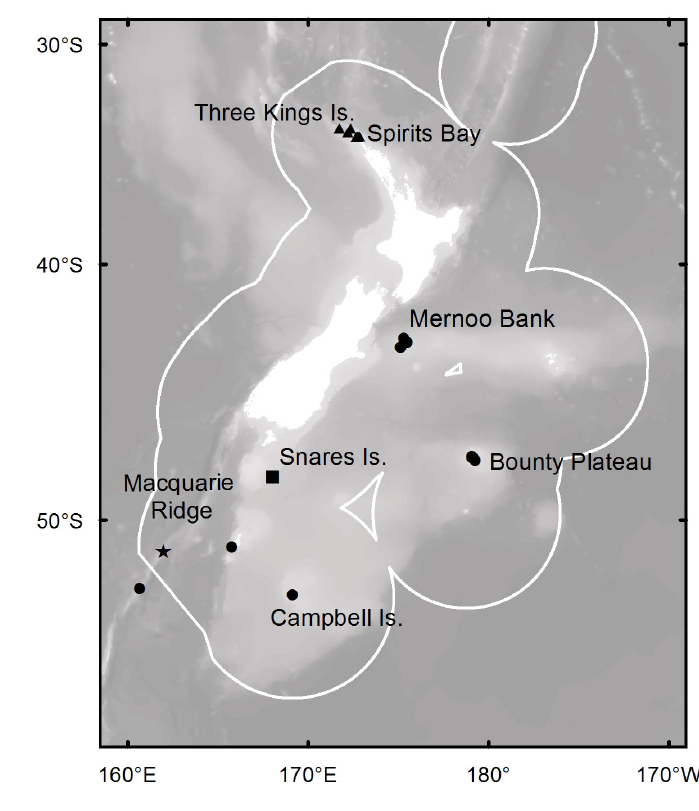
Fig. 1. Study area showing the collection localities for: Lamellomorpha strongylata Bergquist, 1968, around Middlesex Bank, Three Kings Islands, and Spirits Bay (triangles); L. australis Kelly & Cárdenas sp. nov., Bounty Platform, Campbell Plateau, Solander Trough, and Macquarie Ridge (Australian EEZ) (circles); Poecillastra ducitriaena Kelly & Cárdenas sp. nov., on the eastern edge of the Snares Platform (square); and Poecillastra macquariensis Kelly & Cárdenas sp. nov., on Seamount 5, Macquarie Ridge